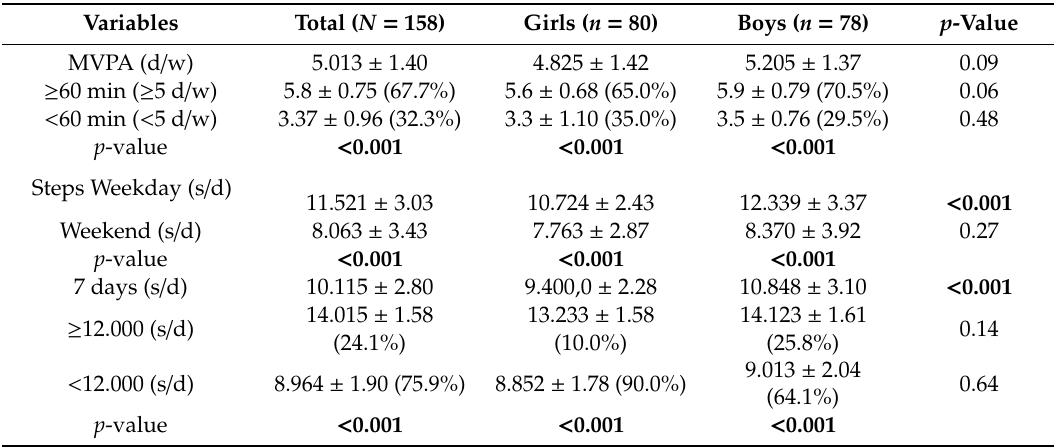
Table 2. Descriptive statistics (mean, standard deviation and frequency) of PA of the participants.